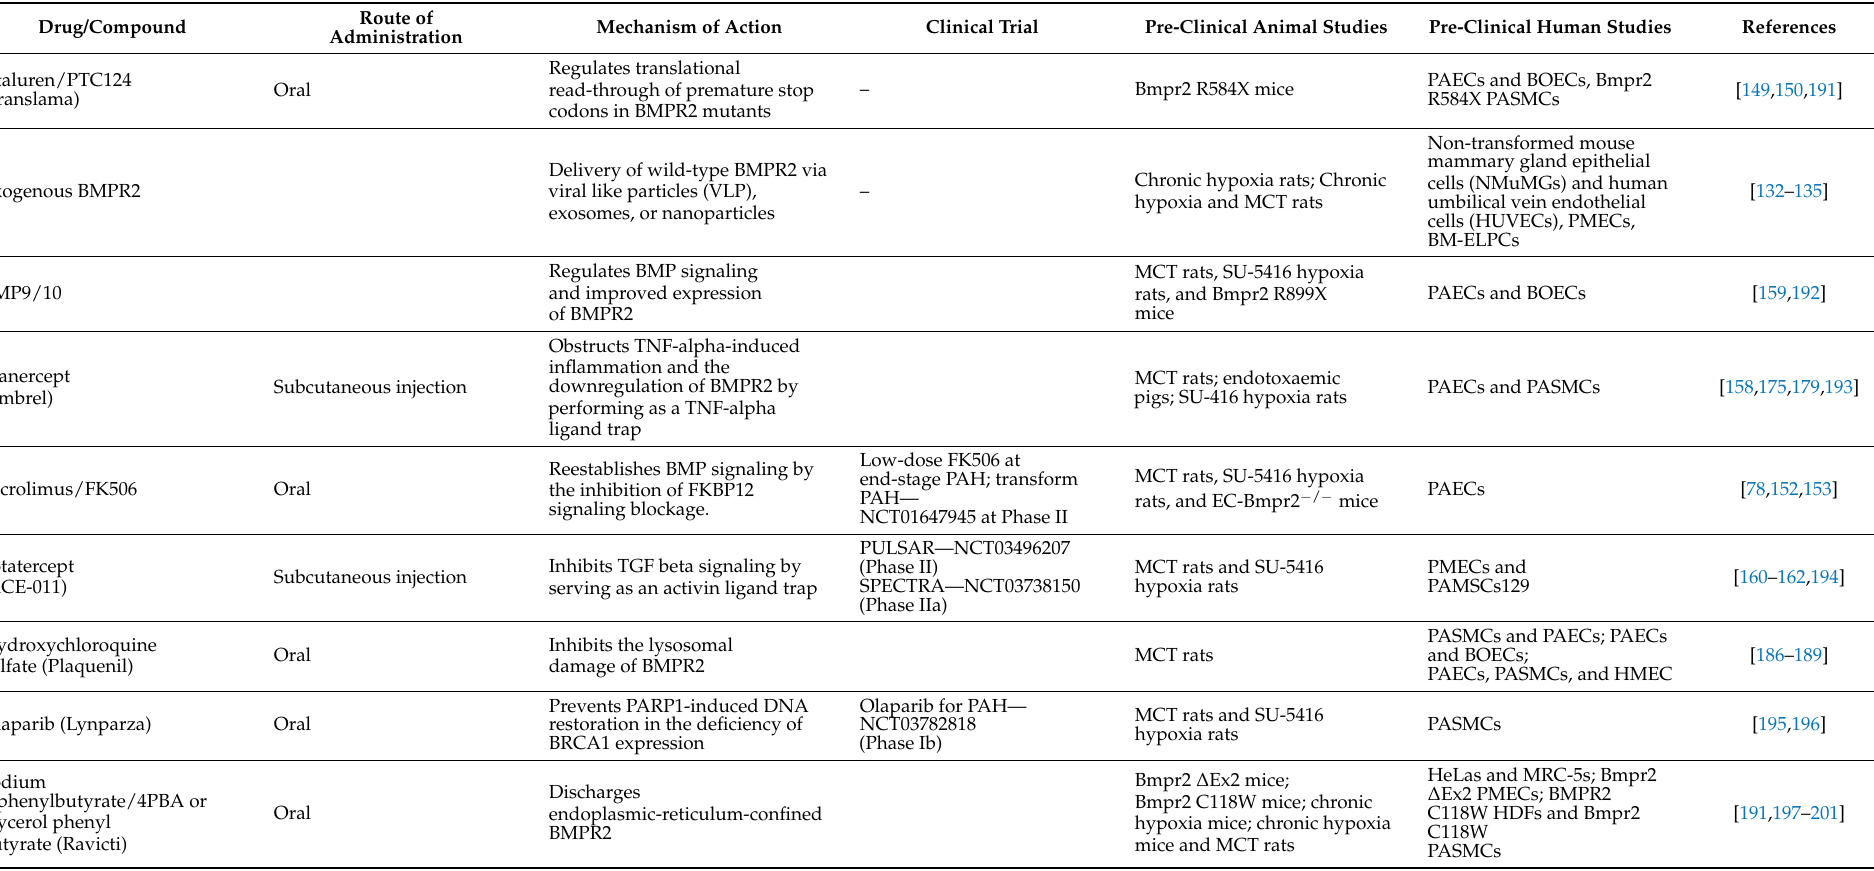
Table 2. Overview of prospective therapeutic drug target steering via BMPR2 and BMP signaling in pulmonary arterial hypertension